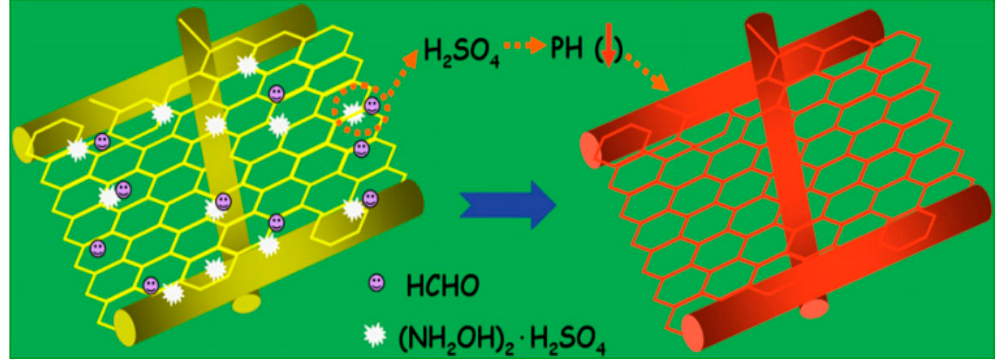
Figure 12. Illustration of the colorimetric detection of formaldehyde based on the nylon 6 nano-fiber/nets (NFN) membrane [165]. Reprinted from the Sensors and Actuators B: Chemical, Vol. 163, Xianfeng Wang, Yang Si, Jialin Wang, Bin Ding, Jianyong Yu, and Salem S. Al-Deyab, A facile and highly sensitive colorimetric sensor for the detection of formaldehyde based on electro-spinning/netting nano-fiber/nets, 187 (2012) with permission from Elsevier.